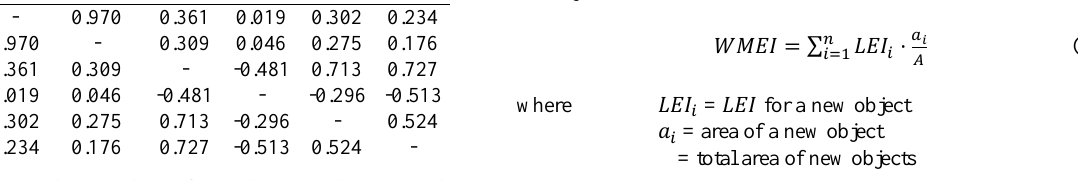
Table 1. Correlation values of the selected multi-temporal indices